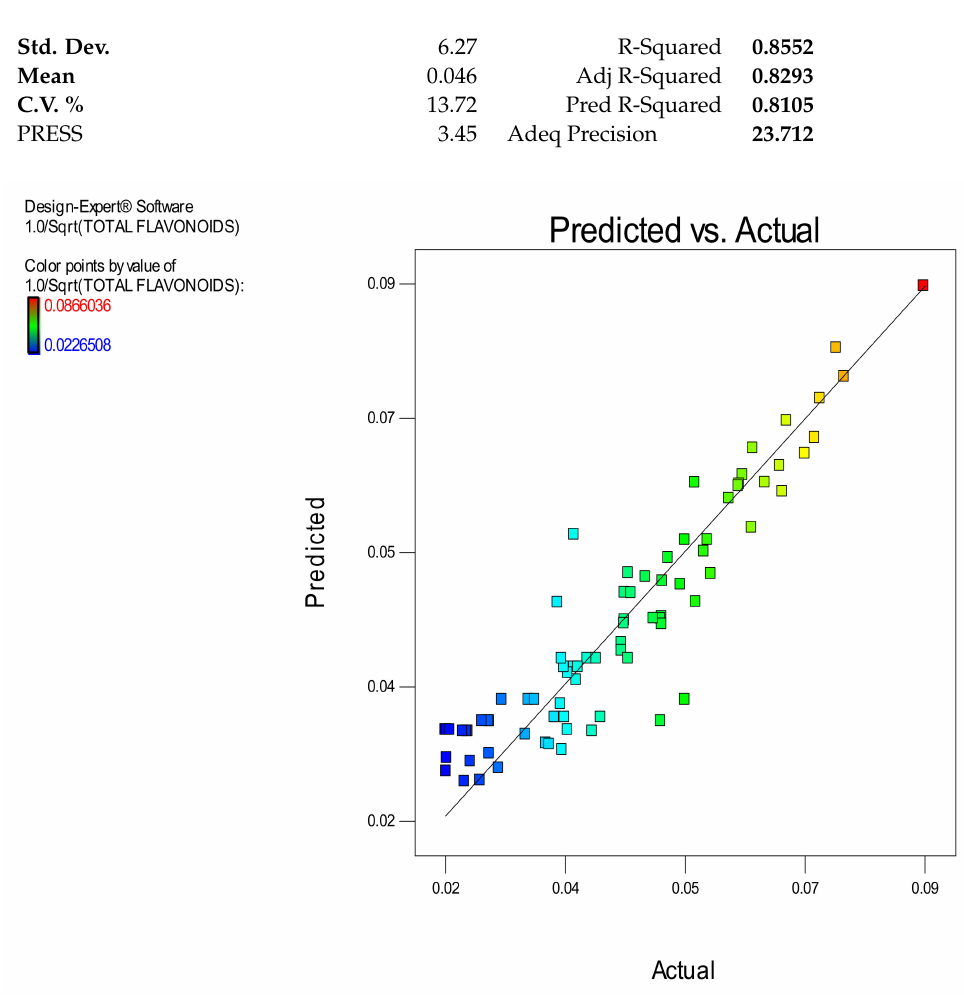
Figure 5. Correlation of Predicted vs. Actual values of the amount of extracted orange pomace total flavonoids.